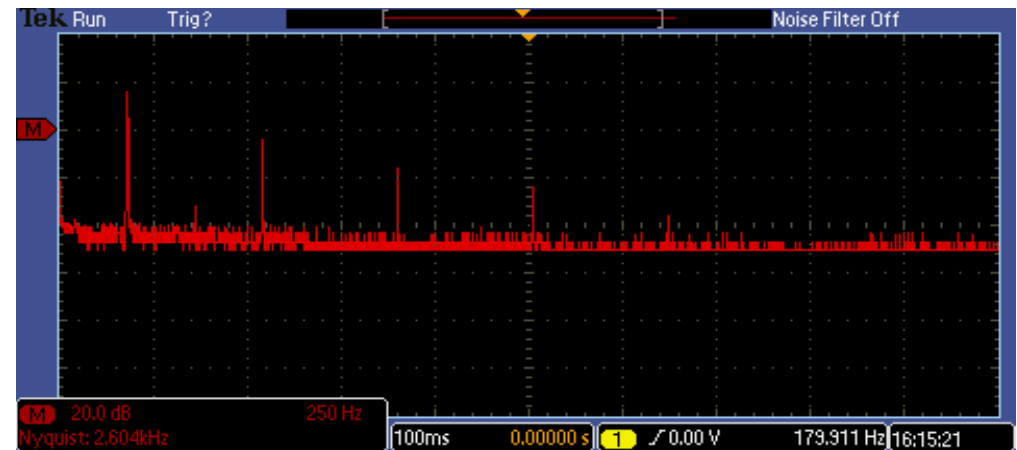
Figure 7. Spectrum of the signal applied to the fiber stretcher. All disturbances above 2 kHz are canceled to avoid fiber stretcher resonances. Amplitude scale: 20 dB/division. Horizontal scale: 250 Hz/division.